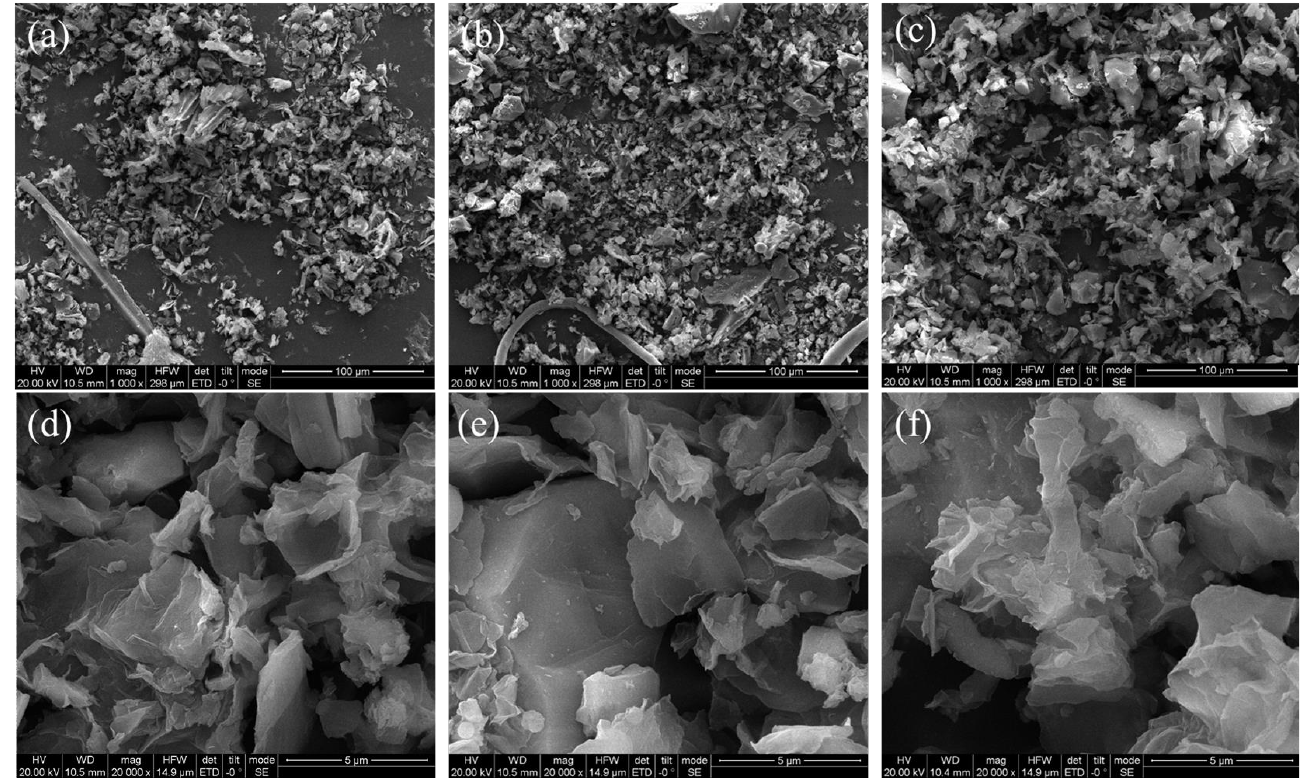
Figure 3. SEM images of GO ( a , d ), AGO ( b , e ), and HGO ( c , f ).